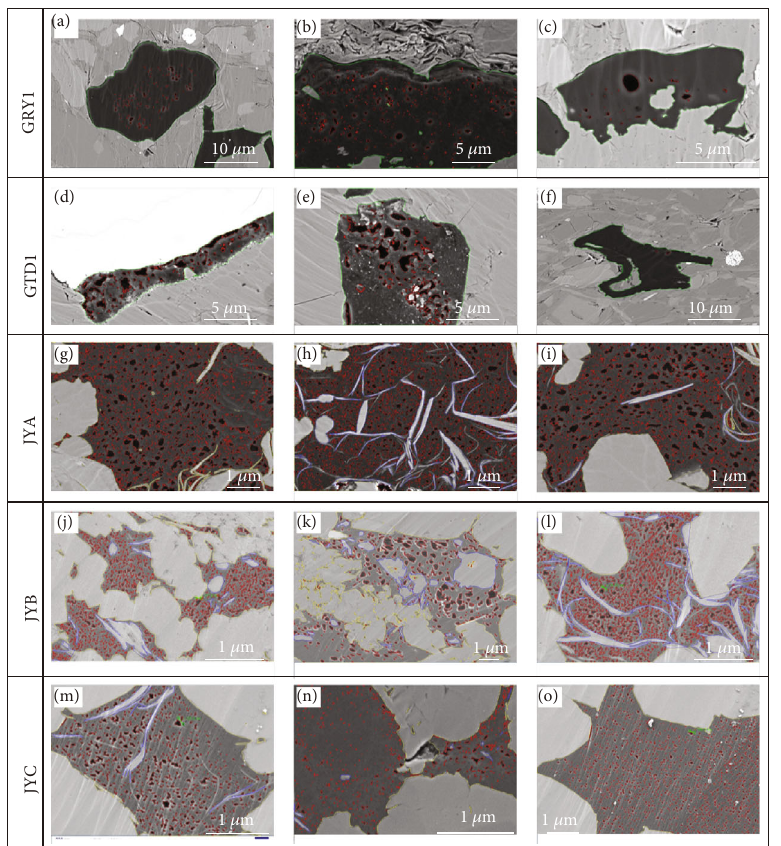
Figure 17: SEM photos of surface porosity identi fi cation in the study area and Jiaoshiba